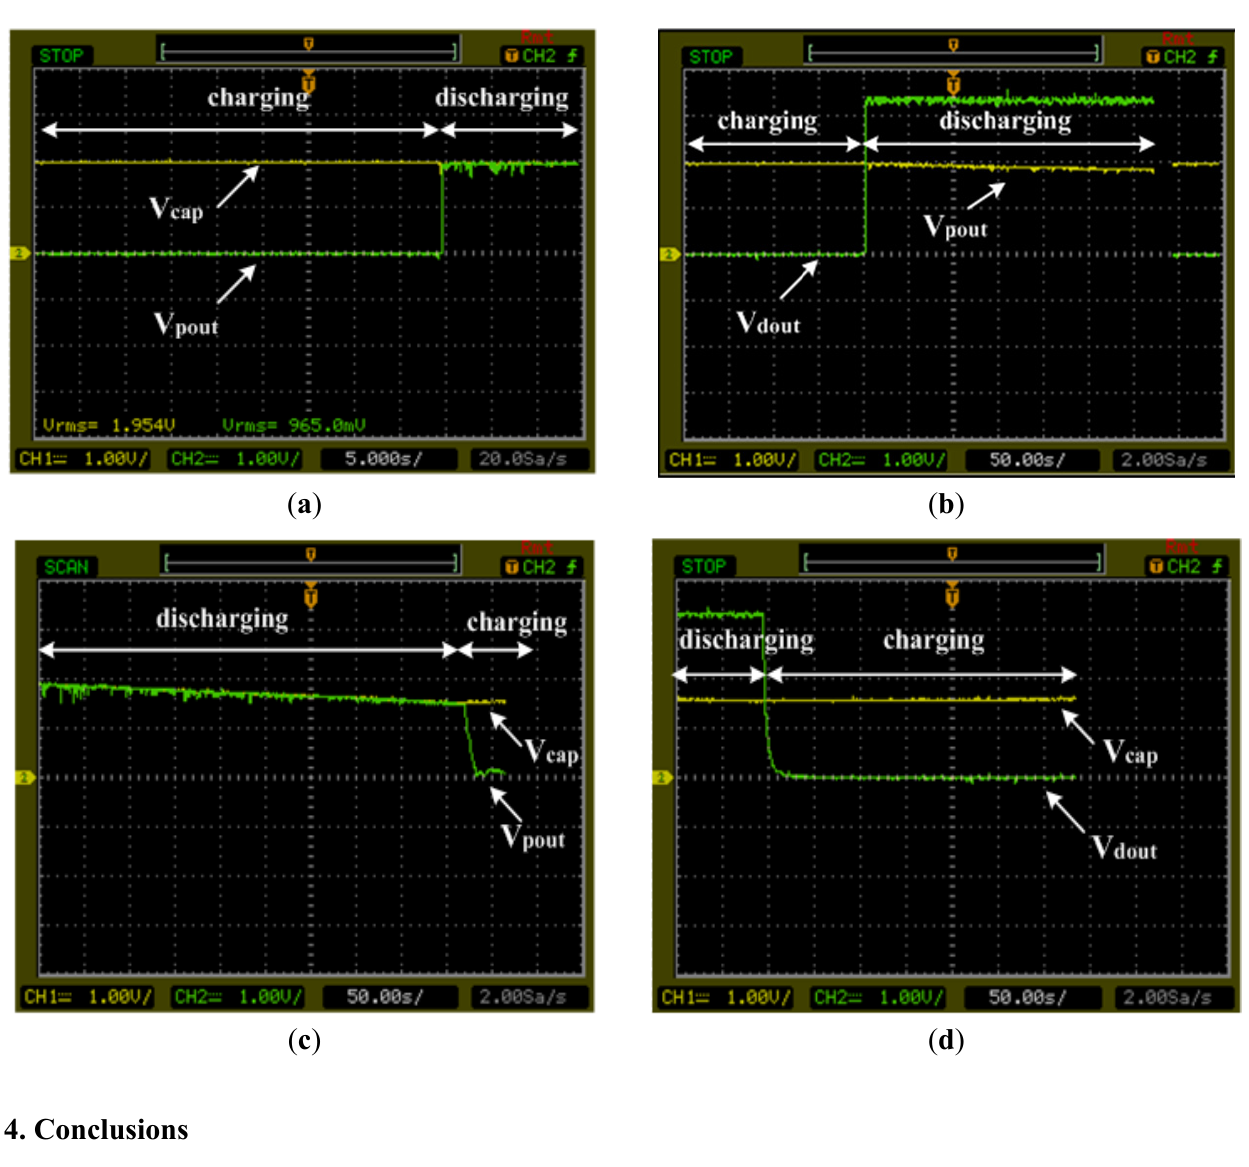
Figure 14. Voltage changes during the charge and discharge process. ( a ) V from charging to discharging; ( b ) V from discharging to V pout